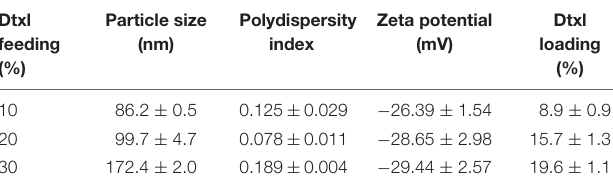
TABLE 3 | Dtxl-8P4 NPs at different Dtxl